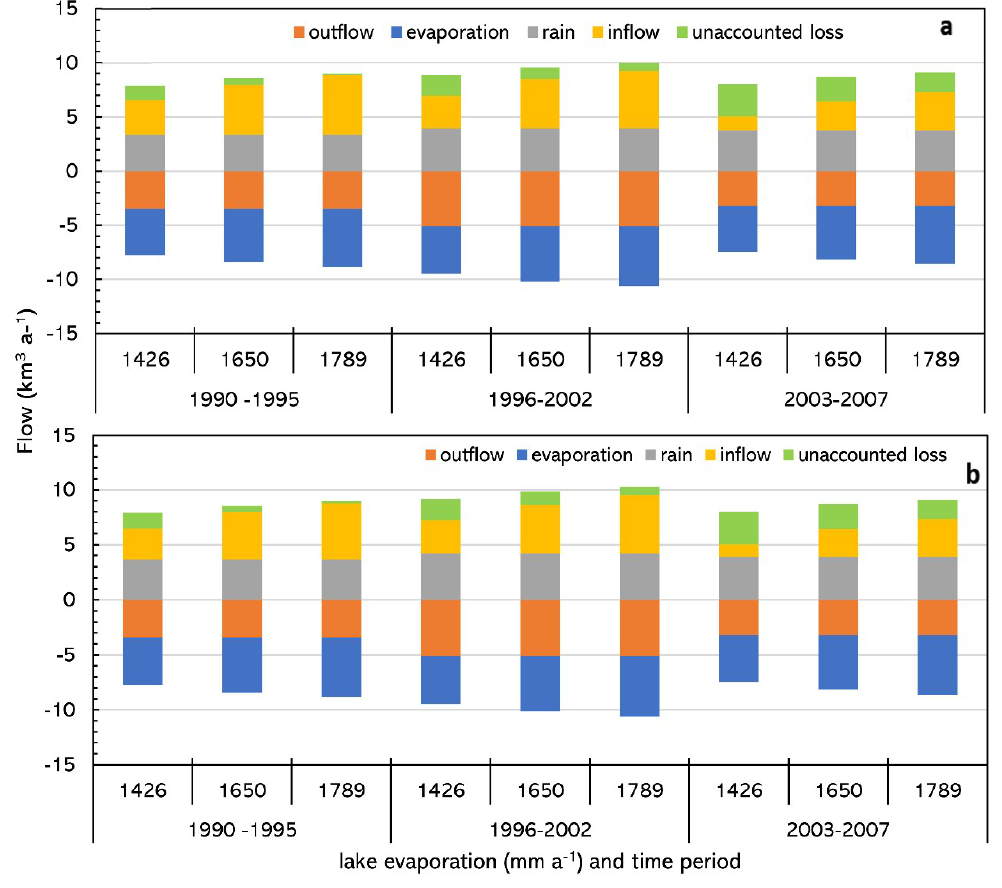
Figure 12. Water balance for Lake Tana for ( a ) land-based precipitation; ( b ) lake and land-based precipitation. See Figure 3 for the location for the locations of the stations. Table A1 lists the numerical values for each component of the water balance.